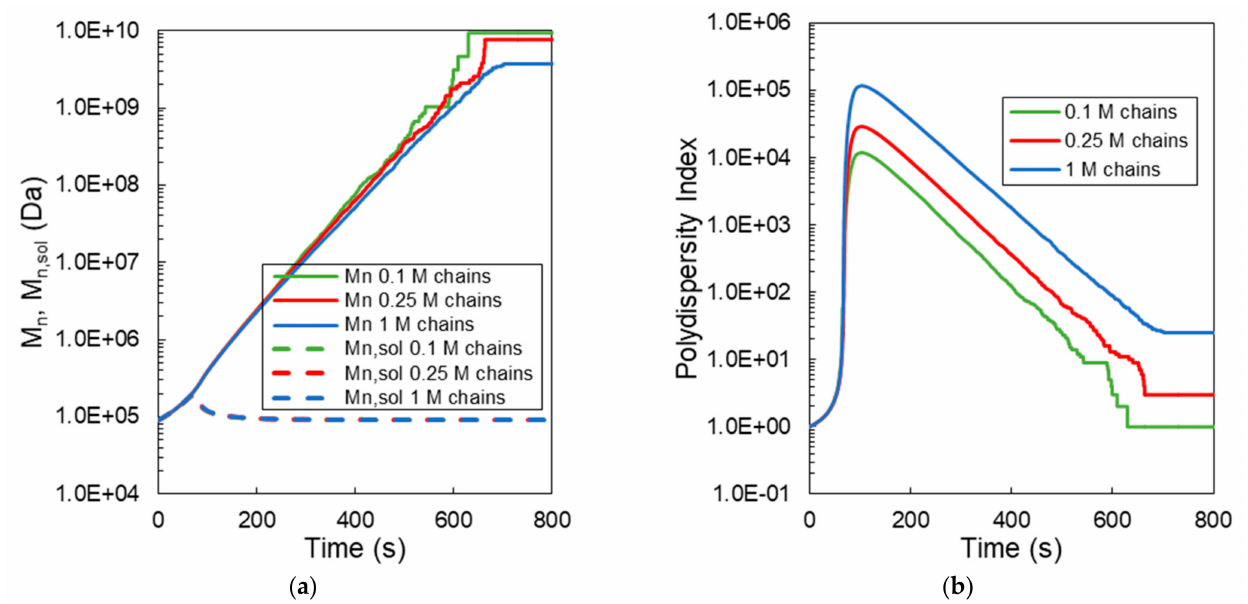
Figure 5. Effect of the initial number of polymer chains on the time evolution of the number of average molecular weights ( M n ) in the system and sol phase ( M n,sol ) ( a ) and Polydispersity Index in the system ( b ) for a HA-Tyr solution (i.e., 1.75% w/v , MW = 90 kDa, 0.124 units/mL HRP and 728- µ M H 2 O 2 ) [8].